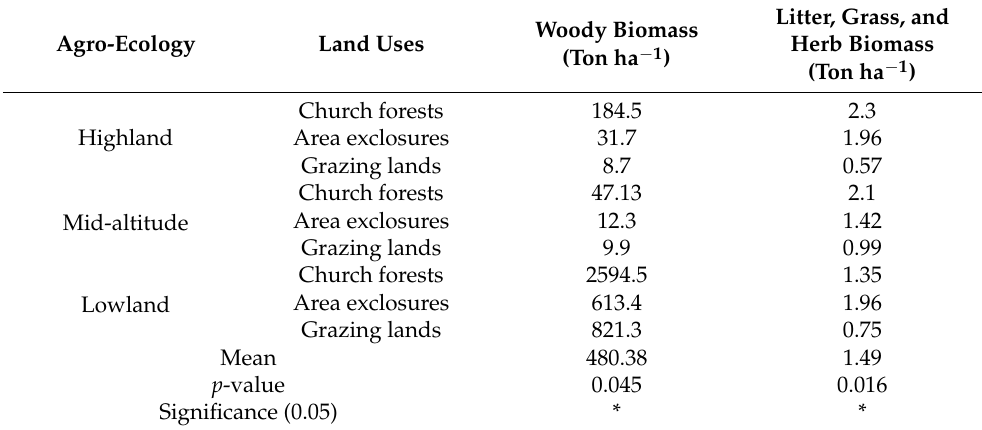
Table 6. Mean woody, litter, grasses, and herbaceous biomass.